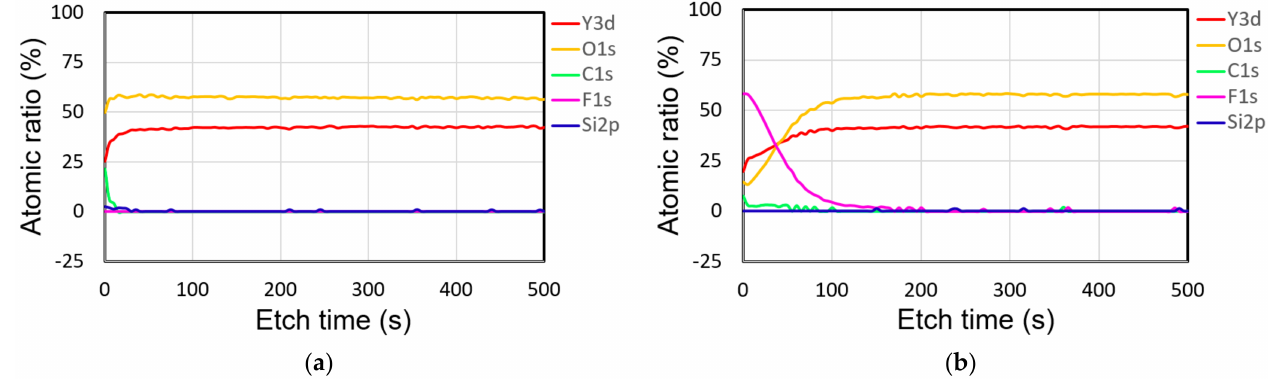
Figure 9. In-depth XPS analyses of as-deposited ( a ) and plasma etched ( b ) Y 2 O 3